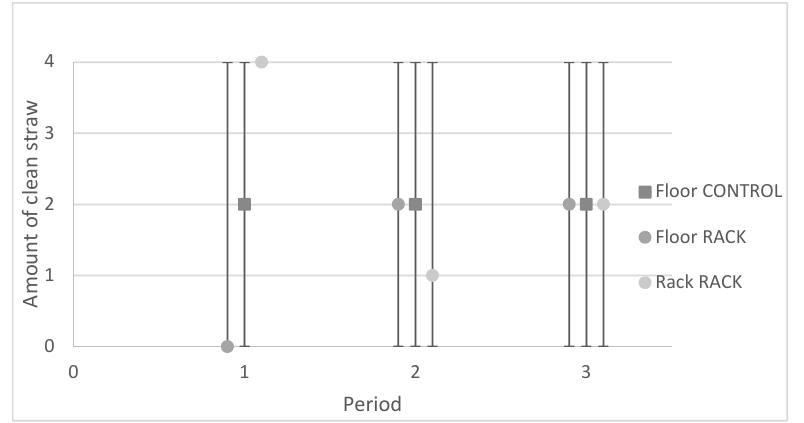
Figure 6. The median amount of clean straw available in the pens during the different periods. Floor represents the amount of clean straw available on the solid pen floor in either CONTROL ( ■ ) or RACK ( ● ). Rack represents the amount of straw available in the straw rack in RACK ( ● ). The error bars indicate minimum and maximum observed values. RACK could have straw in both the rack and on the floor (originating from the straw rack) while CONTROL could only have straw on the floor.